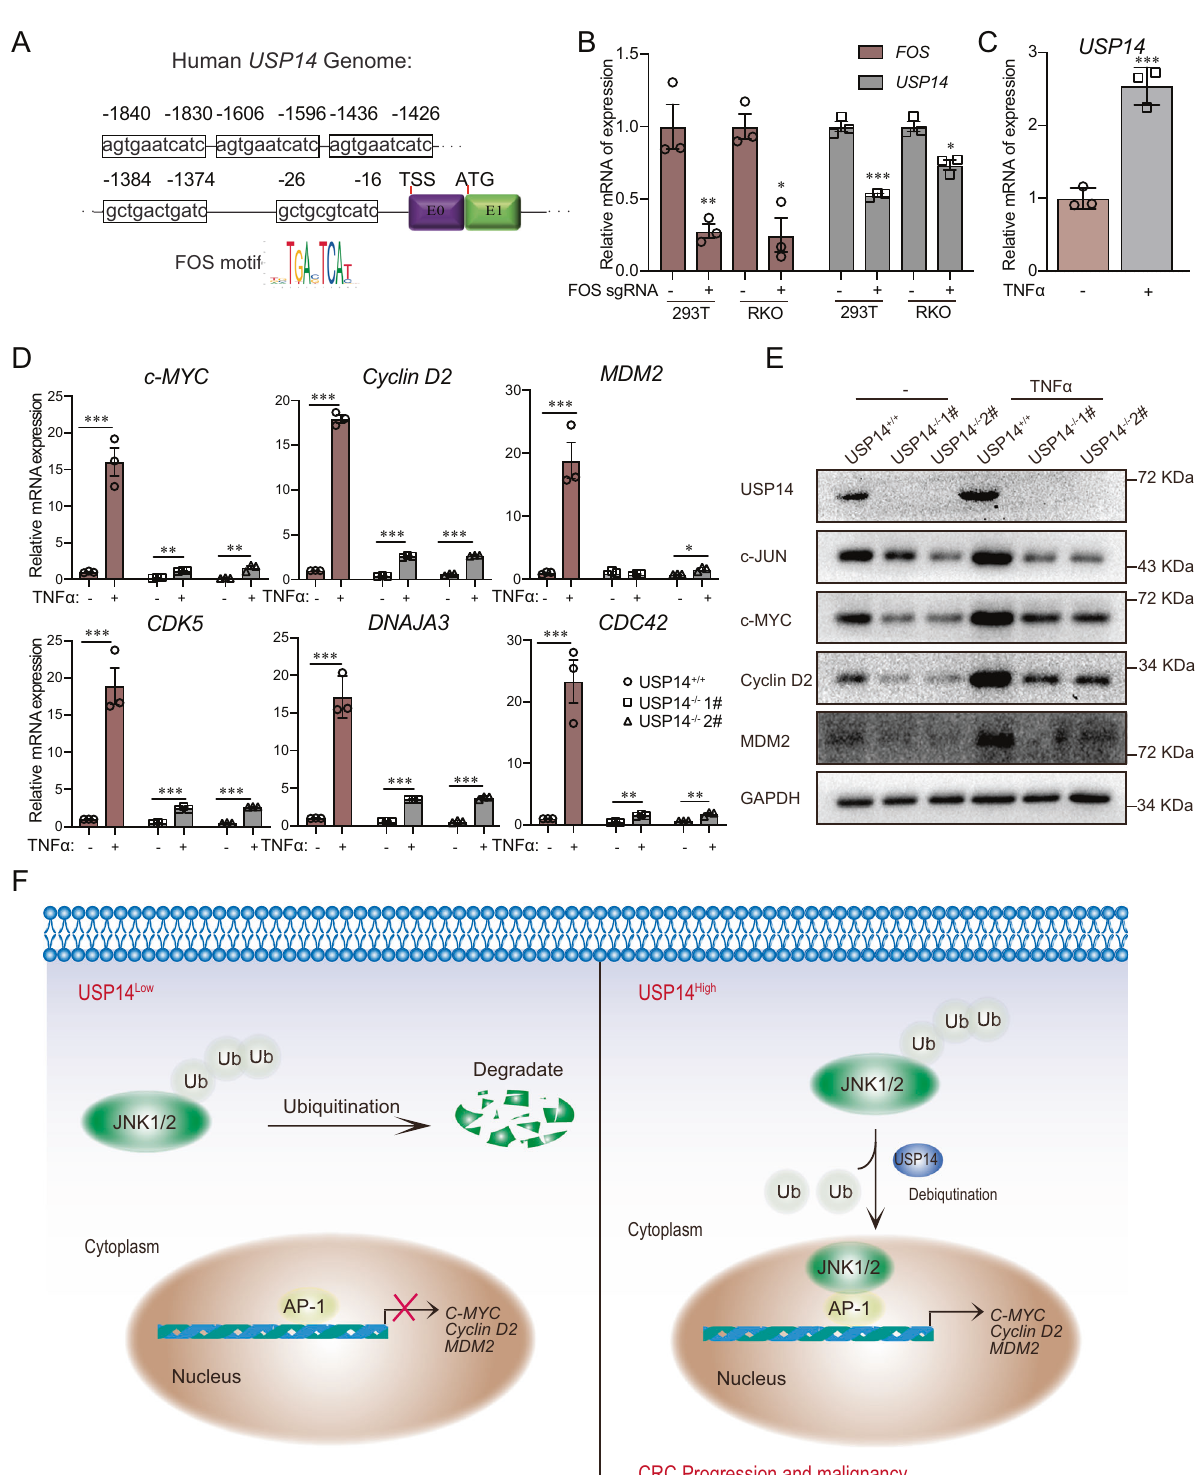
Fig. 7 USP14 is regulated by TNF- α and required for TNF- α -induction of JNK downstream genes. A A schematic of the FOS motif in the human USP14 promoter. B The mRNA level of USP14 in FOS-knockdown cells and wild-type cells ( n = 3). C The mRNA expression of USP14 induced by TNF- α . D The mRNA expression of TNF- α -induced JNK target genes in wild-type and USP14-de fi cient RKO cells ( n = 3). E The protein levels of USP14, c-JUN, c-MYC, Cyclin D2 and MDM2 in wild-type and USP14-de fi cient RKO cells. F Working model showing how USP14 functions as an oncogene to promote tumorigenesis through JNK. The data are presented as the means ± SEM. Statistical signi fi cance was analyzed by ANOVA or Student ’ s t test. * p < 0.05, ** p < 0.01, *** p <